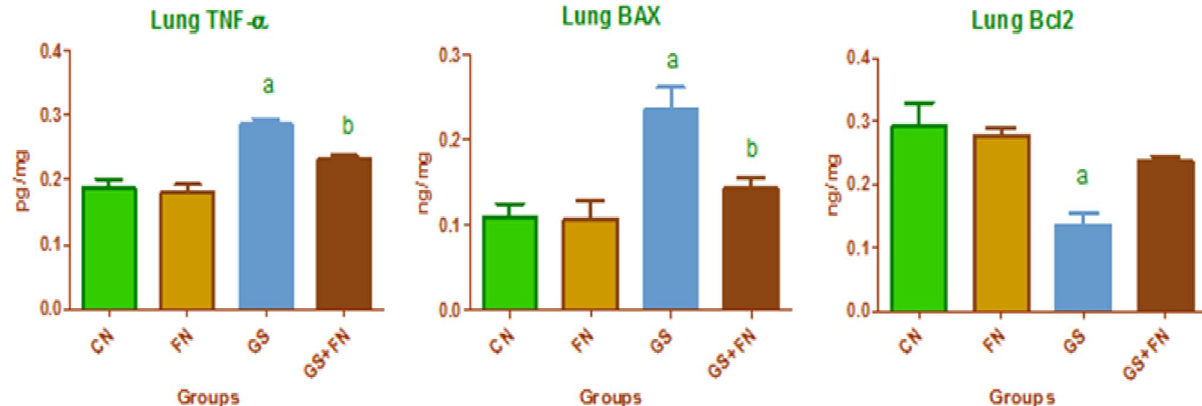
Figure 1. Lung proinflammatory (TNF-α), proapoptotic (Bax), and antiapoptotic (Bcl2) markers in the investigated groups, CN control, FN fenugreek diet, GS gasoline. a,b Superscripts refer to significant changes ( p < 0.05). a: All groups compared to the CN group, b: GS + FN group compared to the GS